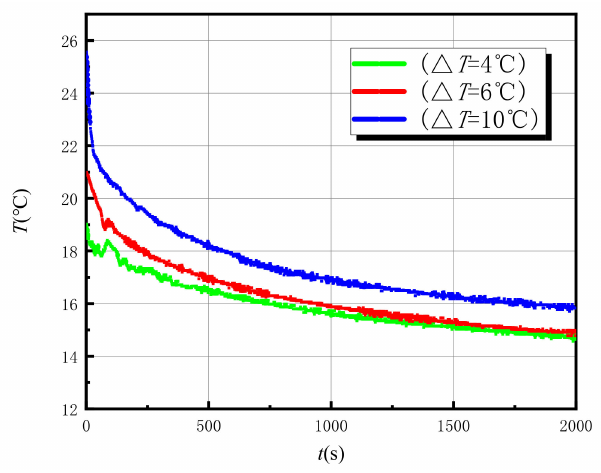
Figure 6. Temperature variation curve of the test well with different excitation strengths during slug heat tests in the case of u =